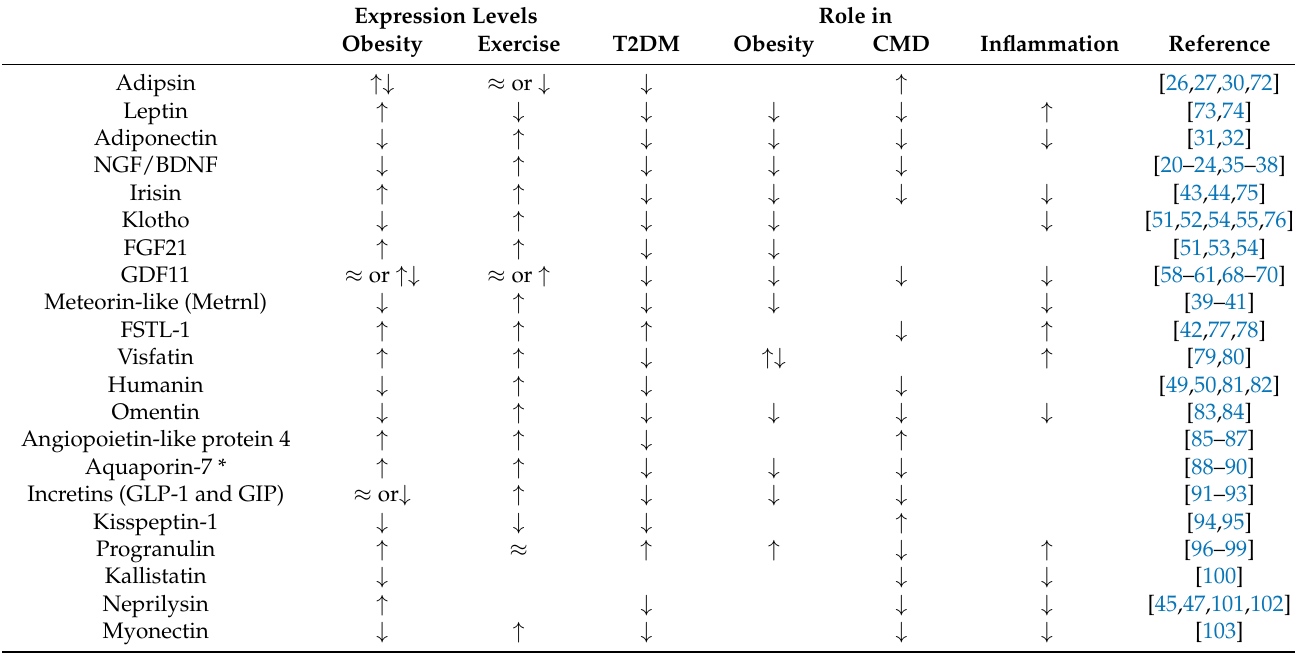
Table 6. A list of endogenous MTFs and their abundance and roles in pathophysiological conditions, such as type 2 diabetes mellitus (T2DM), obesity, CMDs and inflammation.